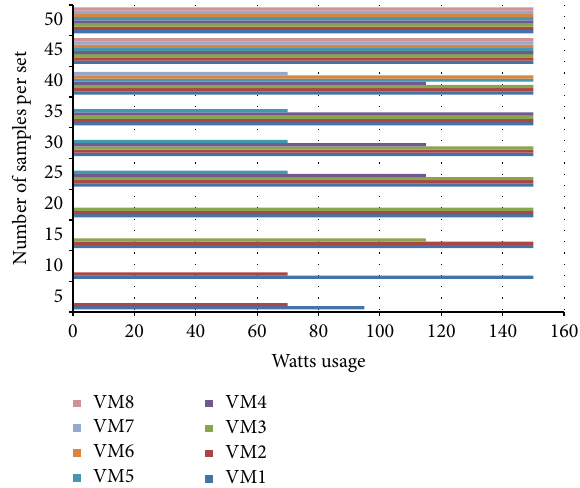
Figure 4: Load on 8 virtual machines for randomly generated requests.